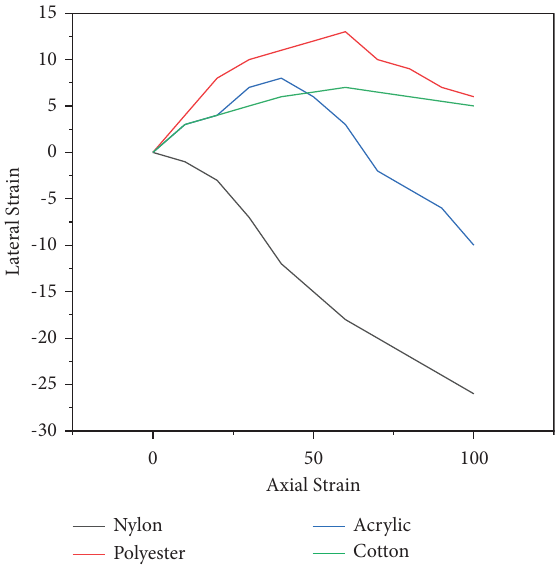
Figure 15: Course-wise expansion in star structure on the ap- plication of